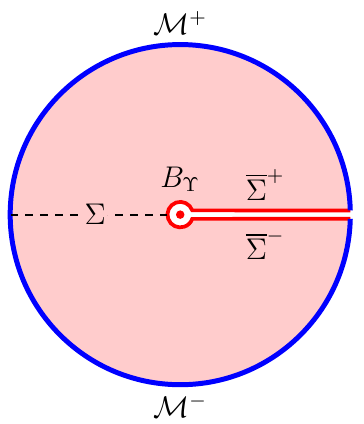
Figure 10. Variations of the action in the presence of discontinuities at (cid:22)(cid:6) lead to new boundary terms at (cid:22)(cid:6) (cid:0) [ (cid:22)(cid:6) + [ B (cid:7) . This modi(cid:12)es the way in which the term at B depends on (cid:14)(cid:30) , and therefore changes